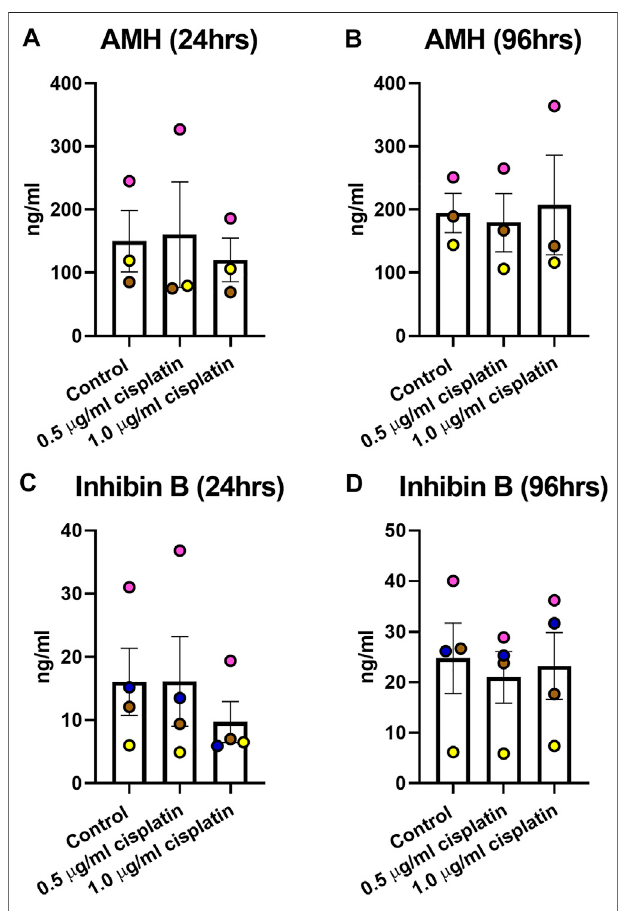
FIGURE 4 | Acute effects of exposure to cisplatin on human fetal testicular function. Measurement of levels of inhibin B (A,B) and anti-M ϋ llerian hormone [AMH; (C,D) ]in culture medium of human fetal testicular tissues at 24 and 96 h post-exposure. No differences in the levels of inhibin B and AMH were detected at 24 or 96 h post-exposure to 0.5 μ g/ml and 1.0 μ g/ml cisplatin. Data analysed using two-way ANOVA. Values shown are means ± SEM and each set of coloured data point represents an individual fetus ( n = 3 –